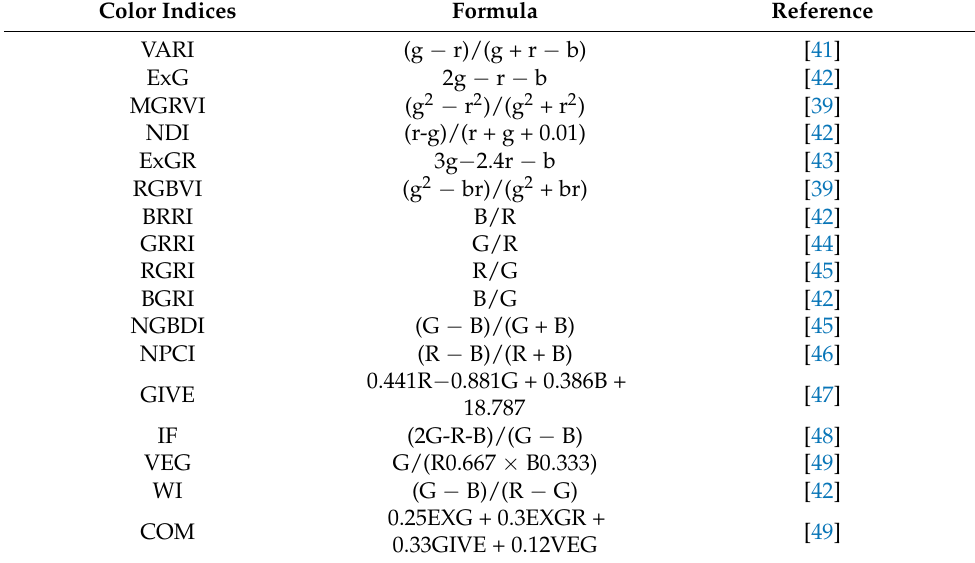
Table 2. CIS used in this